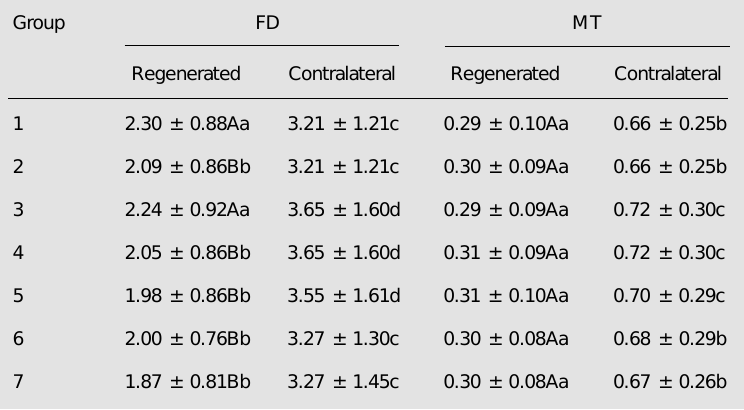
Table 2 - Fiber diameter (FD) and myelin thickness (MT) obtained at the polyethylene tube midpoint 4 weeks after graft transplantation. Both values obtained for the regenerated and contralateral nerves are presented. 1) Donor: C57BL/6J (C), recipient: F1 (C x A); 2) donor: A/J (A), recipient: F1 (C x A); 3)